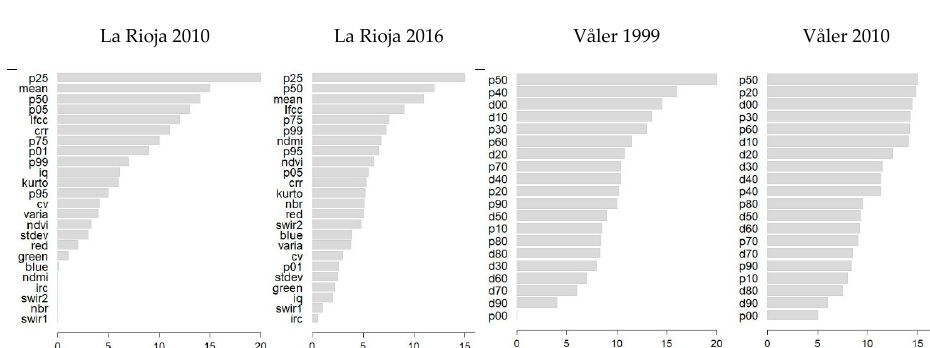
Figure 3. Random forests (RF) variable importance. Note: Height percentiles (ranging from the 0th to 99th percentile: p00, p01, …, p95 and p99); canopy densities (ranging from the 0th to 90th canopy density: d00, d10, …, d90); lfcc: Forest canopy cover; varia: Variance; stdev: Standard deviation; kurto: Kurtosis; iq: Interquartile range; cv: Variation coefficient; crr: Canopy relief ratio; Landsat individual bands (blue, green, red, near infrared (irc) and two shortwave infrared (swir1 and swir2) ndvi: Normalized difference vegetation index; nbr: Normalized burn ratio; and ndmi: Normalized difference moisture index. Remote Sens. 2019 , 11 , x FOR PEER REVIEW